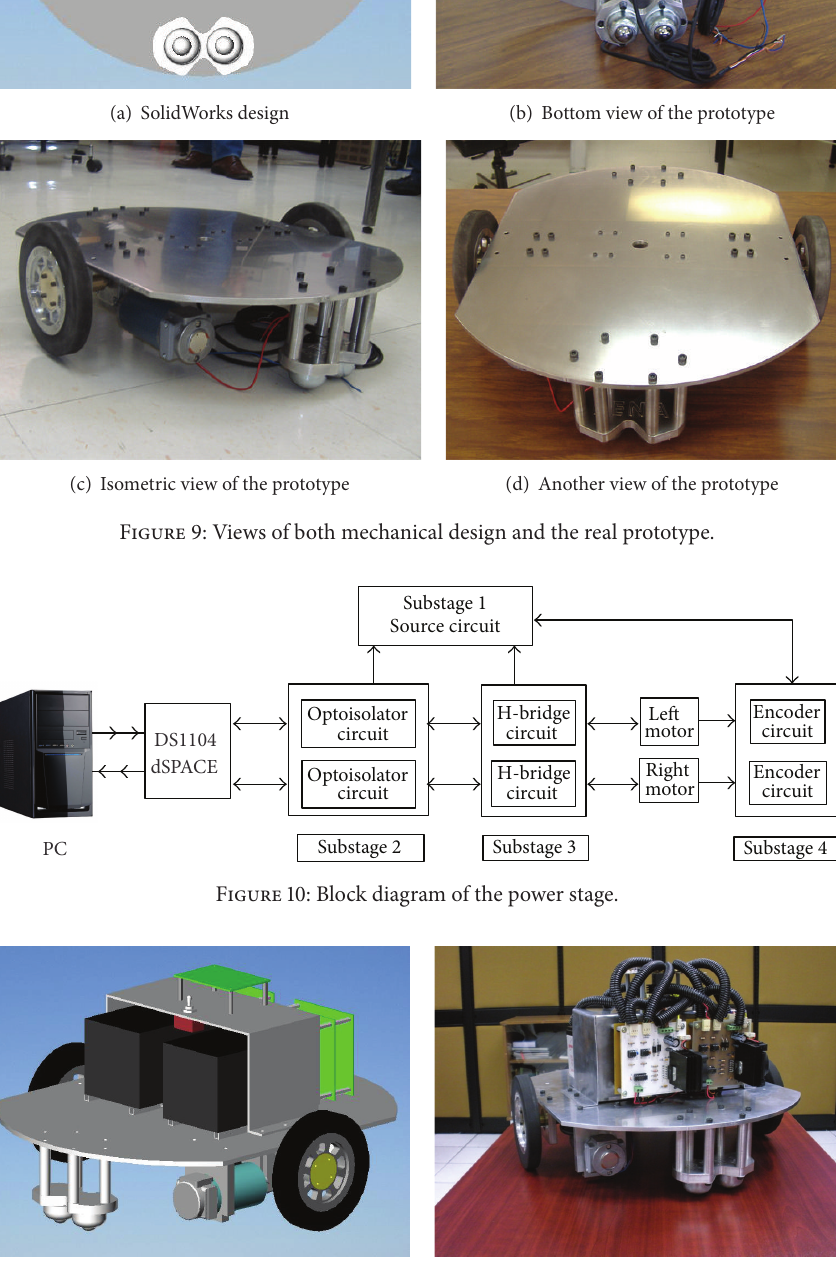
Figure 11: The complete